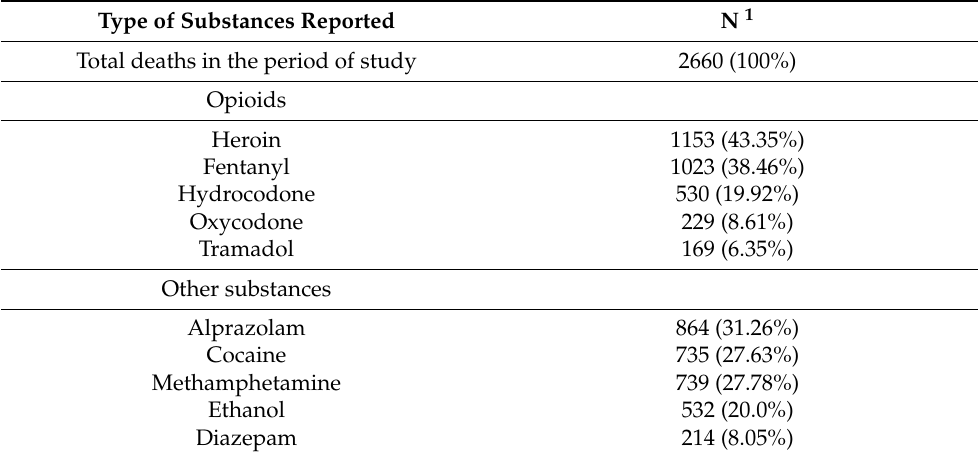
Table 2. Types of substances reported in 2660 opioid-related overdose deaths in the metropolitan Houston area from 2015–2021.